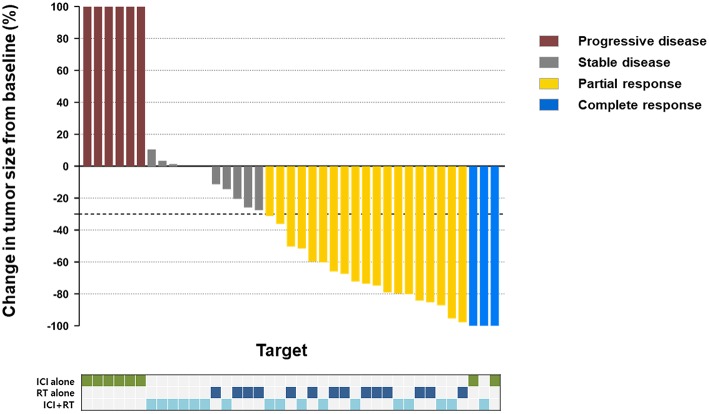
Waterfall plot of best responses of all lesions according to the treatment groups.